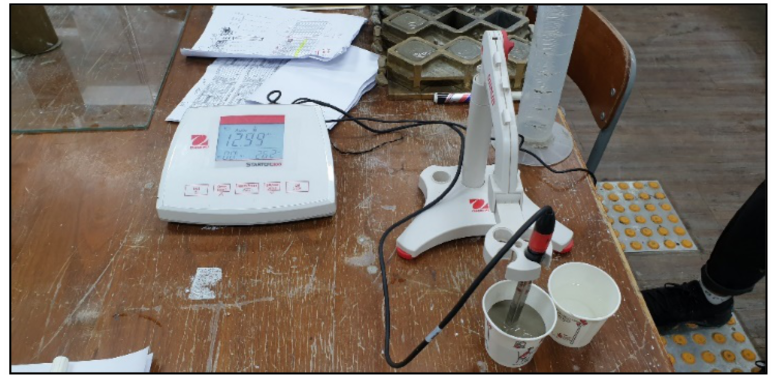
Figure 4. OHAUS starter3100 for measuring pH and